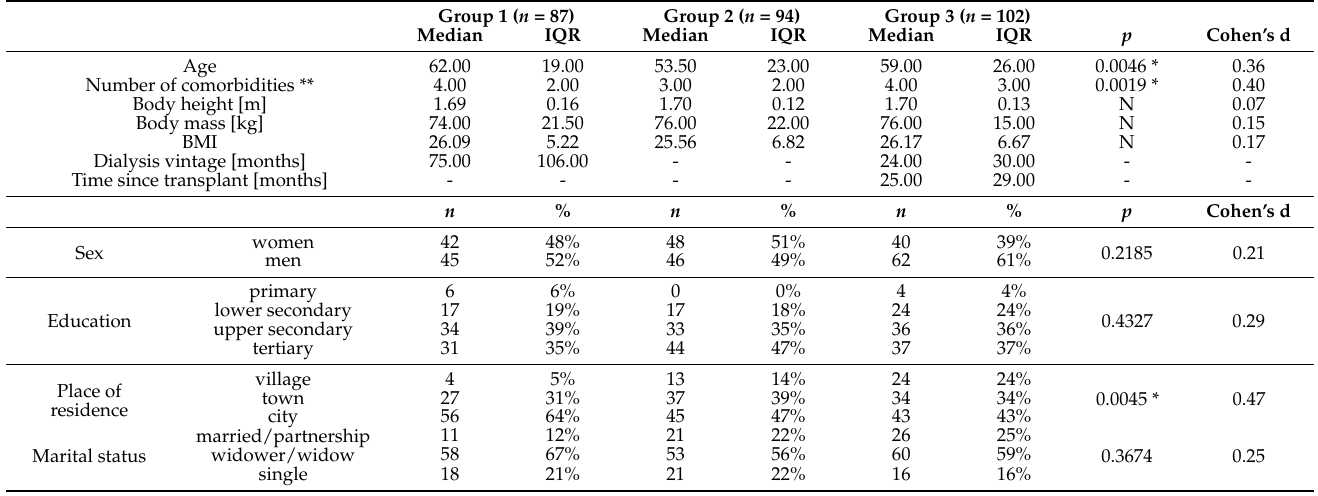
Table 1. Characteristics of study groups and significance of differences between groups for selected variables (the Kruskal– Wallis one-way ANOVA